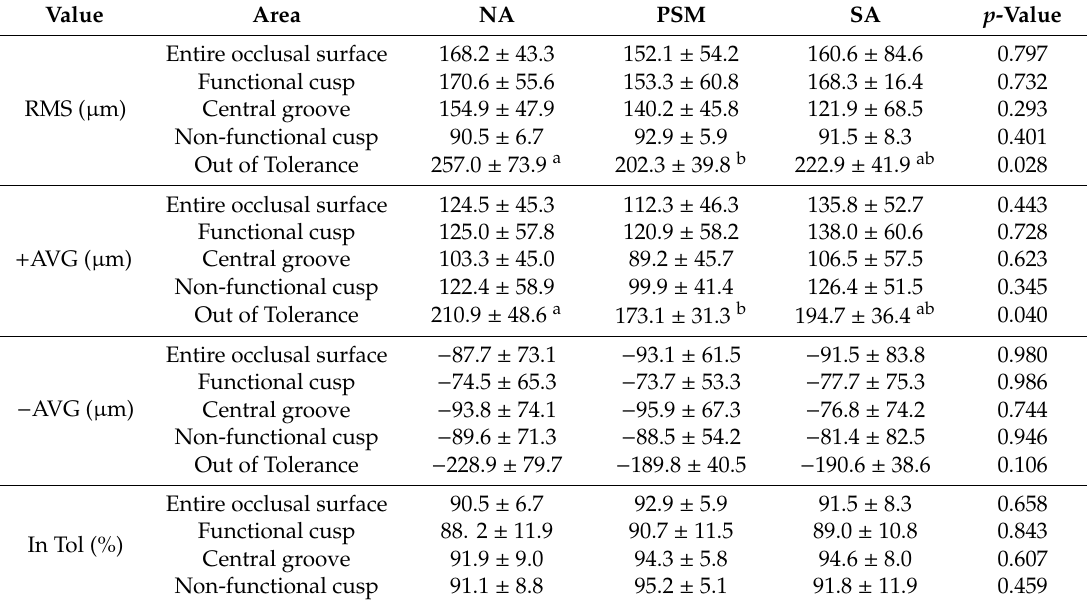
Table 1. Analysis of the representative values for occlusal error between three groups (NA, PSM, and SA). Data are presented as mean ± standard